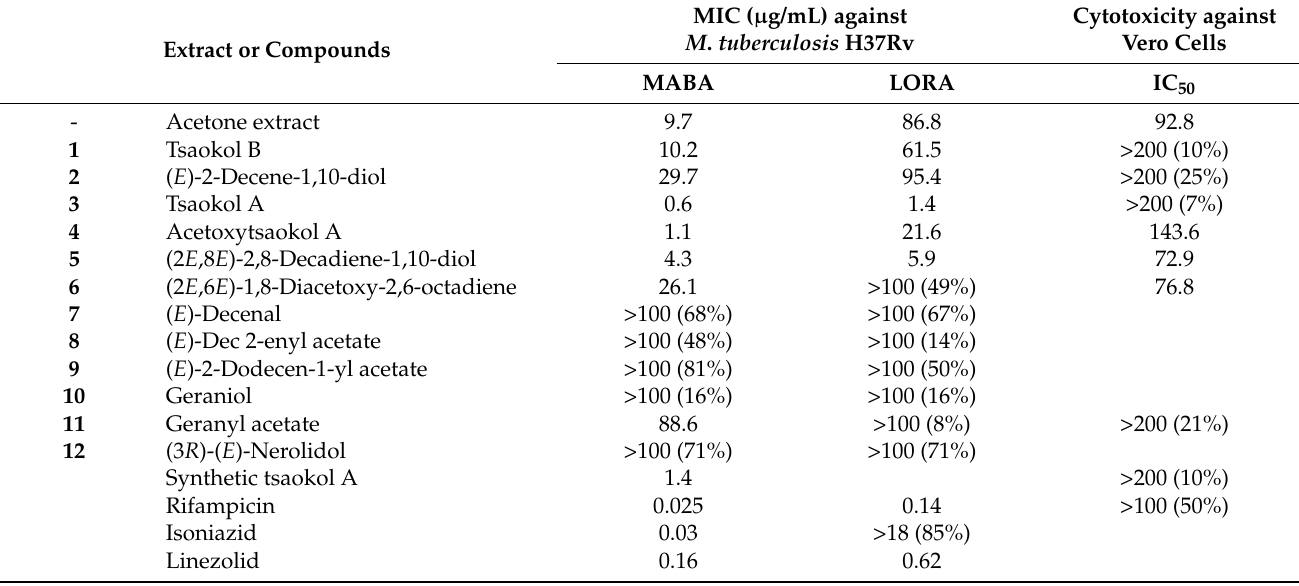
Table 2. Activity of compounds 1 – 12 isolated from the fruits of A . tsao - ko and synthetic Tsaokol